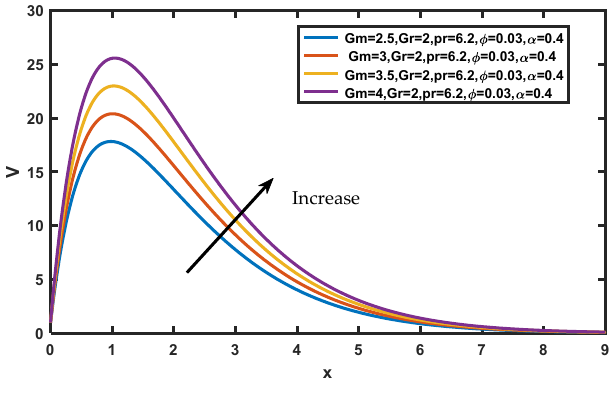
Figure 3. Variation of Gr in v .